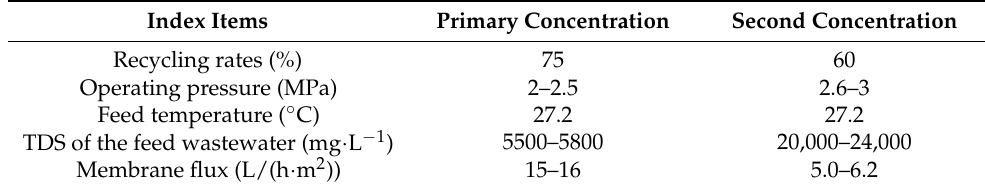
Table 4. NF multistage concentration experimental